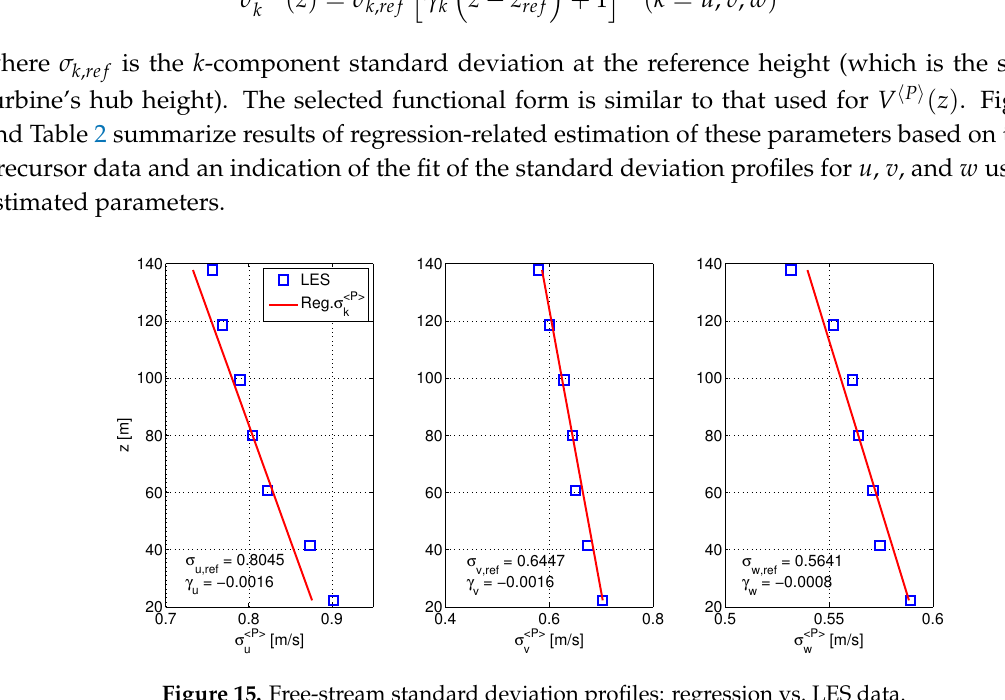
Figure 15. Free-stream standard deviation profiles: regression vs. LES data. Table 2. Free-stream standard deviation profile regression